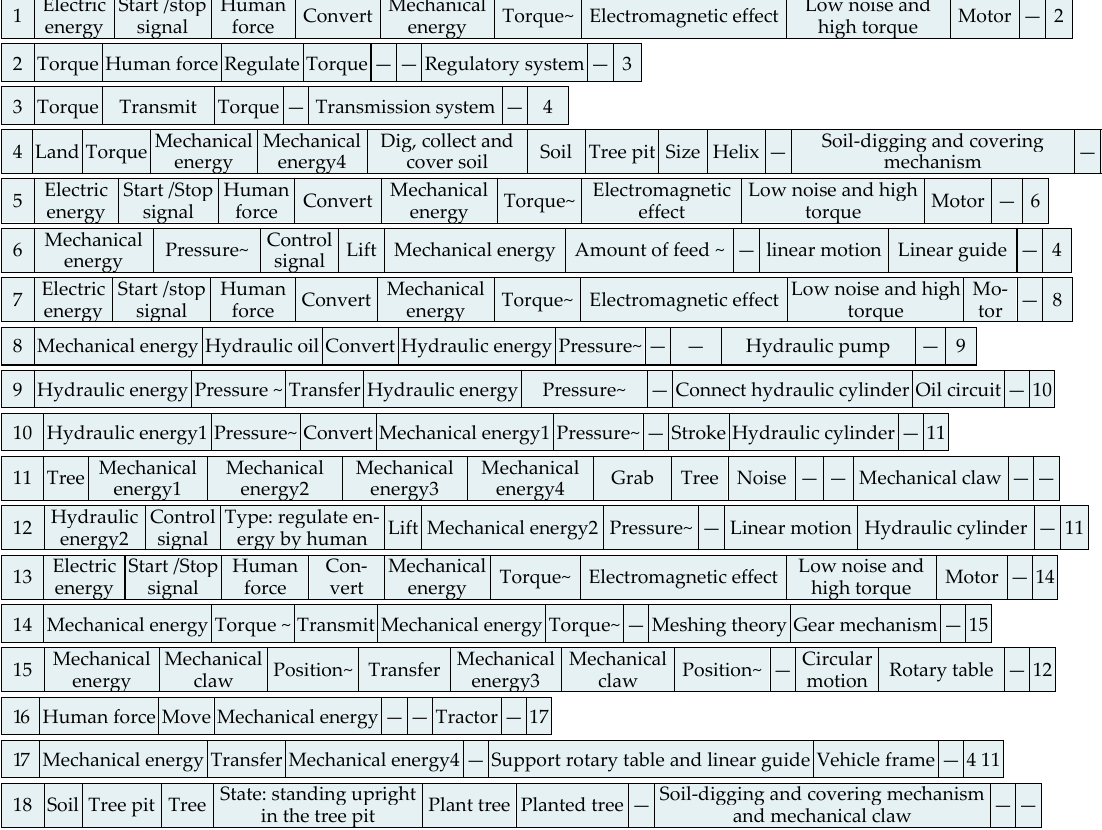
Figure 30. The new tree-planting machine product genome. Figure 30. New tree-planting machine product genome.